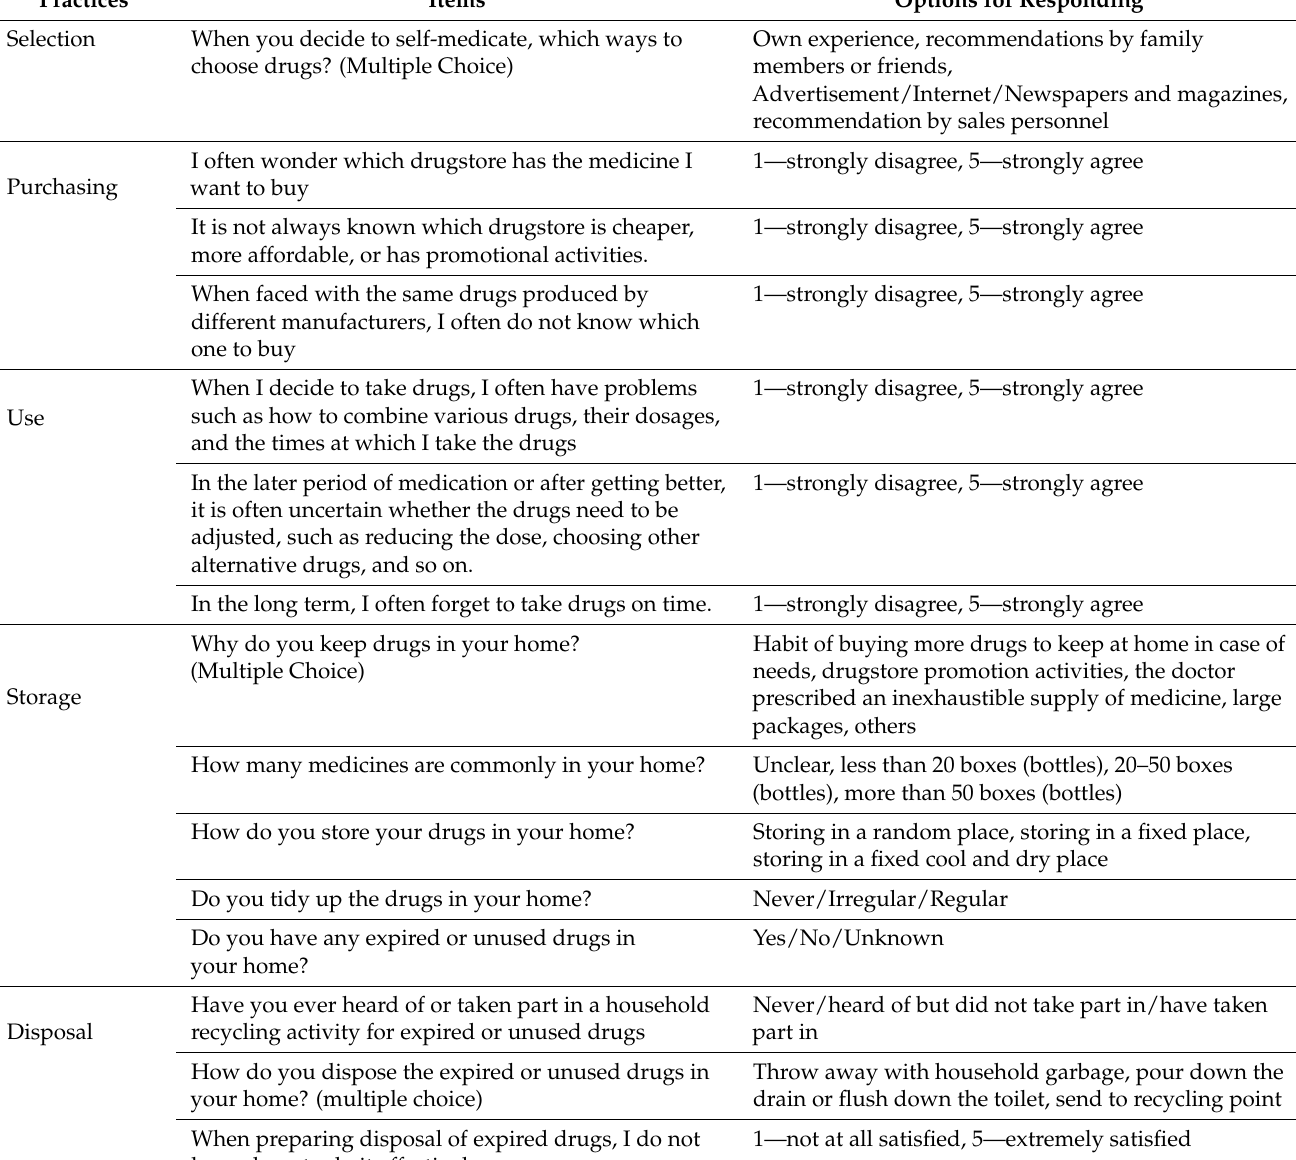
Table A1. Questions (items) of household drugs